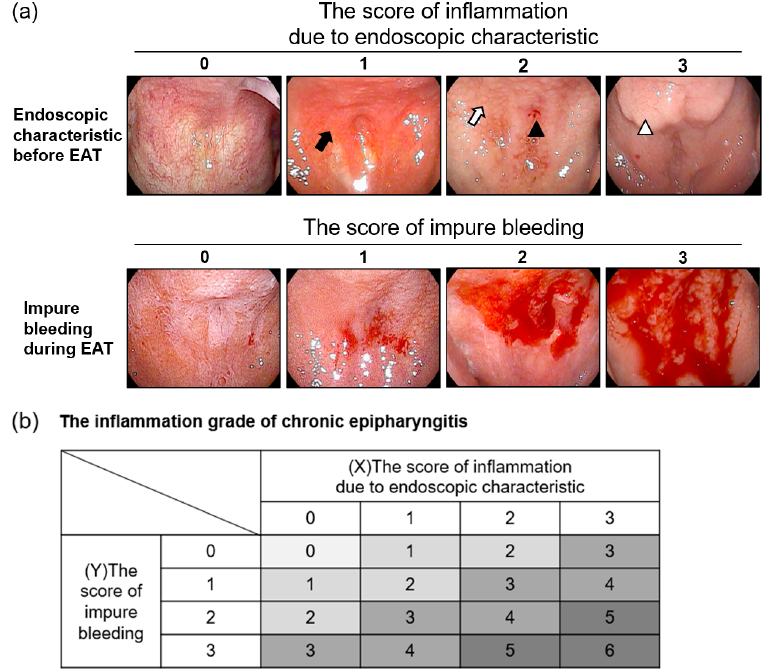
Figure 2. The inflammation grade of chronic epipharyngitis. ( a ) The endoscopic findings of chronic epipharyngitis. The upper panels show the endoscopic characteristics before epipharyngeal abrasive therapy (EAT). The score of inflammation was assessed using endoscopic characteristics. The black arrow indicates redness of the mucosa. The white arrow indicates cobblestone-like granular changes. The black triangle indicates submucosal bleeding. The white triangle indicates severe mucosal swelling. The lower panels show impure bleeding during EAT, which correlates with the intensity of inflammation. The score of impure bleeding was evaluated by the degree of bleeding. ( b ) The inflammation grade of chronic epipharyngitis was calculated using (X) the score of inflammation due to endoscopic characteristics and (Y) the score of impure bleeding. The inflammation grade of chronic epipharyngitis was scored on a scale of 0–6 (0: absent, 1–2: mild inflammation, 3–4: moderate inflammation, 5–6: severe inflammation).